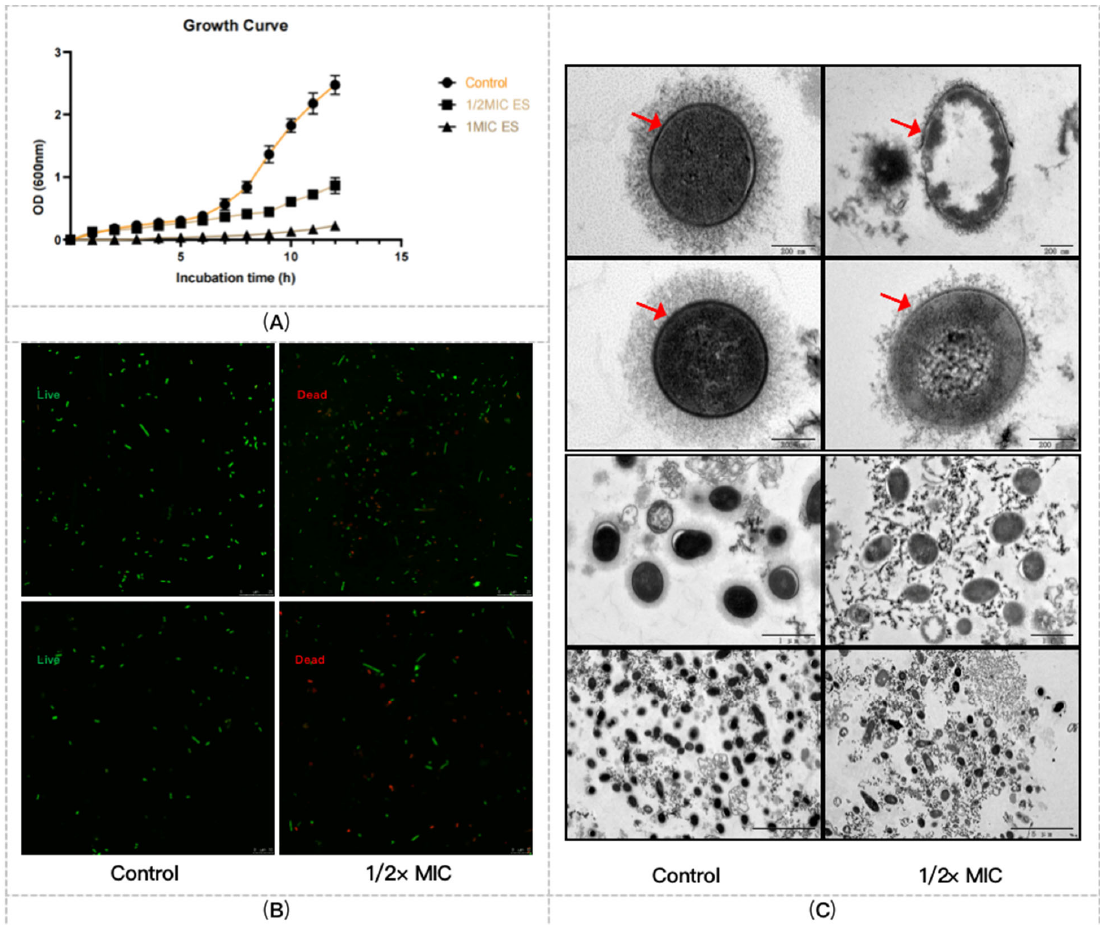
Figure 1. Antibacterial effects of ES on the PRSP F3983. ( A ) Growth curve of PRSP F3983 treated by ES at 1/2× MIC and 1× MIC. ( B ) Representative confocal laser scanning microscopy (CLSM) images of F3983 treated with ES 8 h at 1/2× MIC value comparing with control. The viable bacterial cells were stained green by SYTO9, and the dead cells were stained red by PI. Scales on the images are 25 μ m (top two images) and 10 μ m (bottom two images) as marked on. ( C ) Transmission electron microscopy images of F3983 incubated with the ES at 1/2× MIC value for 8 h compared with control. Red arrowheads point to bacteria with reduced capsule polysaccharides and damaged cell walls.